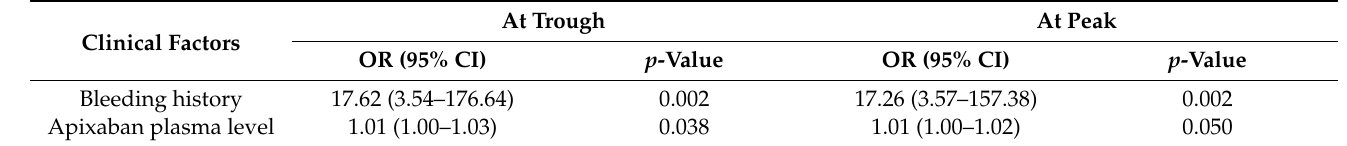
Table 5. Multivariate analysis of the apixaban plasma levels related to bleeding